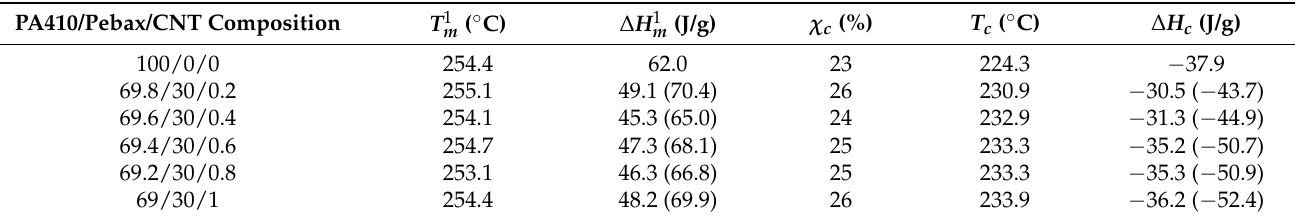
Figure 2. DSC curves of pure PA410, PA410/Pebax 70/30 unfilled blend and, as an example, PA410/Pebax/CNT and PA410/PA6/Pebax/CNT NCs containing 0.6 wt% CNTs. Curves have been shifted in the vertical axis. Table 3. Calorimetric parameters of the PA410/Pebax/CNT NCs. 1 First heating scan. Values in brackets are normalized with respect to the weight fraction of PA410.